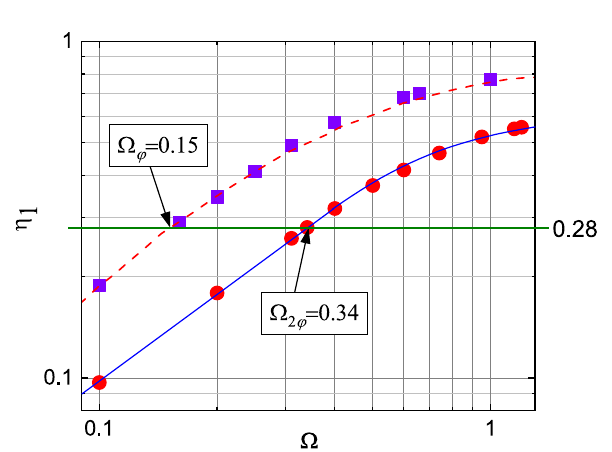
( 2 ) − i ( 1 ) )/ i ( 1 ) 1 1 1 ( 1 ) ( 2 ) 1 and i 1 are the first and second